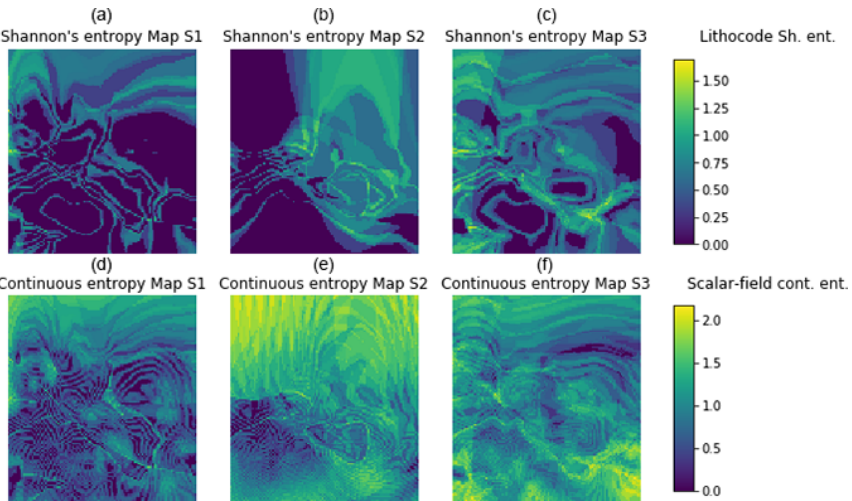
Figure 7. Horizontal sections entropy voxets; (a–c) show Shannon’s entropy over the ensemble of lithocode voxets, (d–f) display the con- tinuous entropy over the ensemble of scalar field voxets; (a) and (d) refer to scenario 1, (b) and (e) to scenario 2 and (c) and (f) to scenario 3.